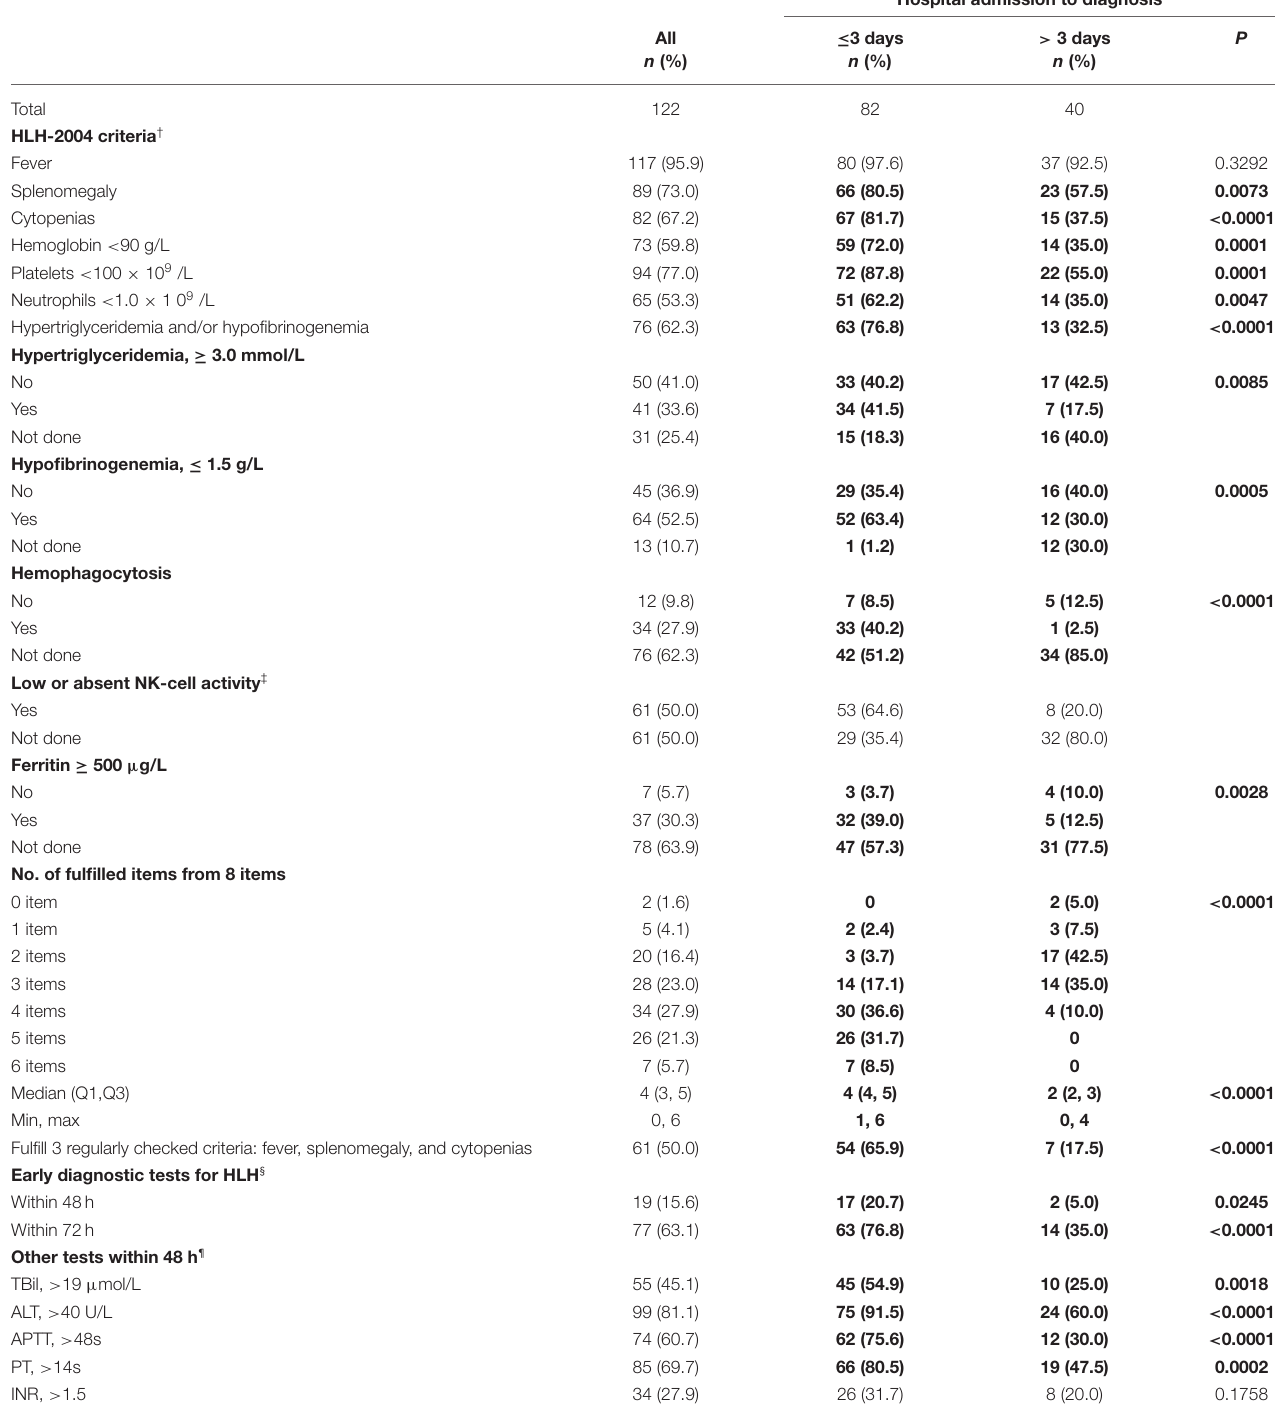
TABLE 3 | Symptoms and laboratory tests within 48h of hospital admission according to HLH diagnostic time lag